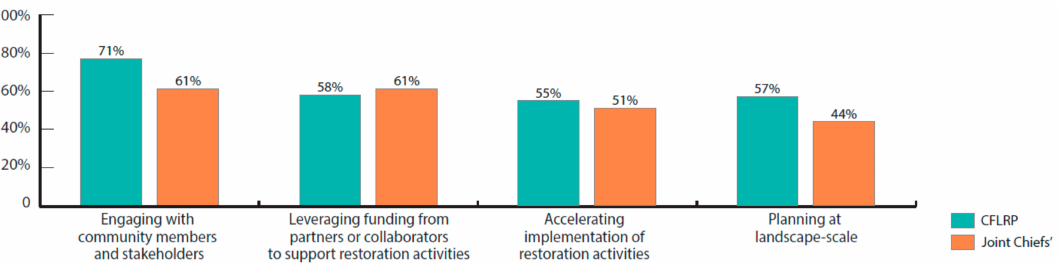
Figure 3. Percent of respondents who identified successful innovations in different areas since receiving CFLRP or Joint Chiefs’ funding. Note: The items in the figures were the ones selected by the most participants and do not include all items included in the respective sections of the